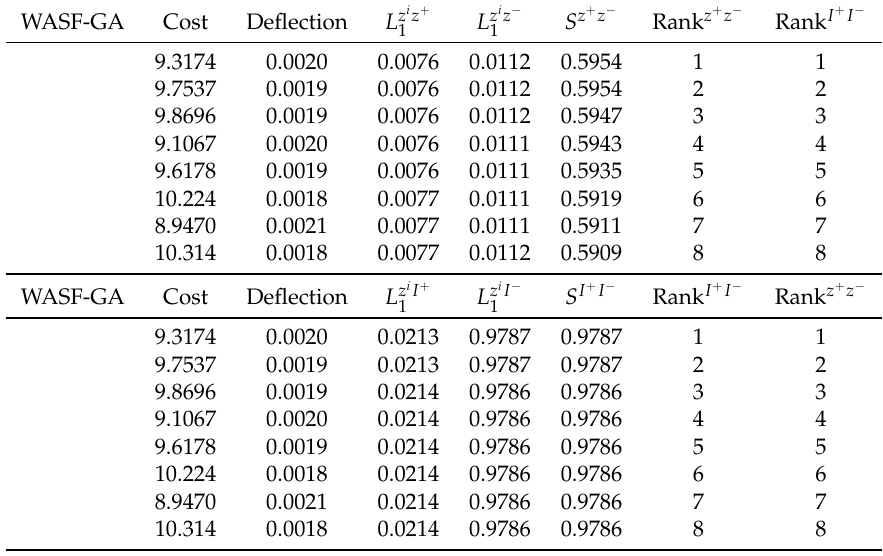
Table 6. TOPSIS ranking results with L 1 metric for WASF-GA, DM’s partial-preferences (15, 0.0025) ( N =